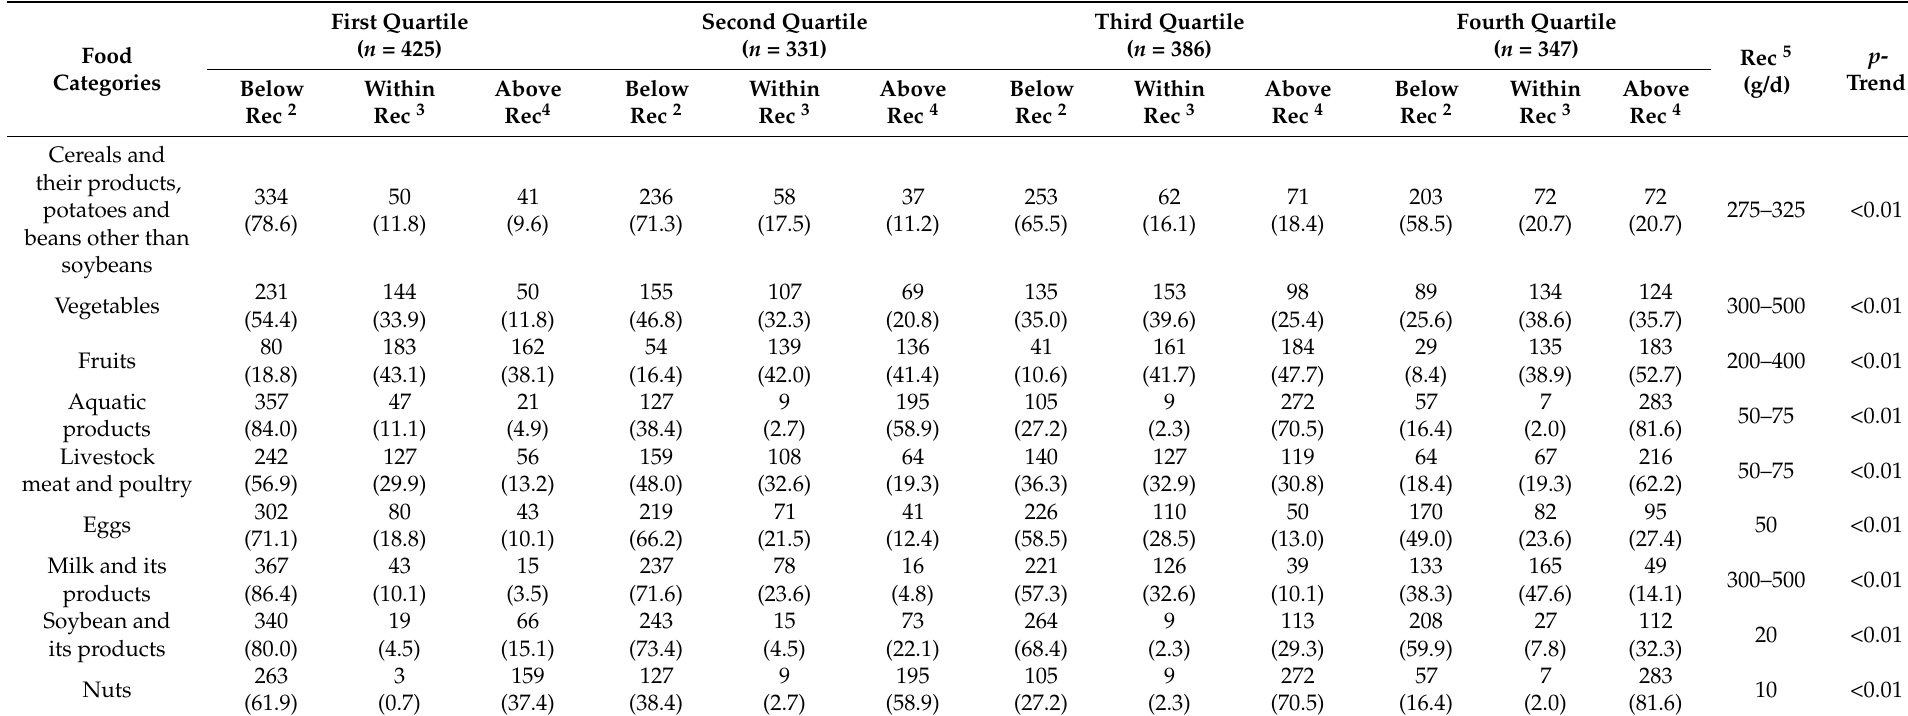
Table 4. The food categories intakes of 1489 participants according to quartile of CDGCI-PW scores 1